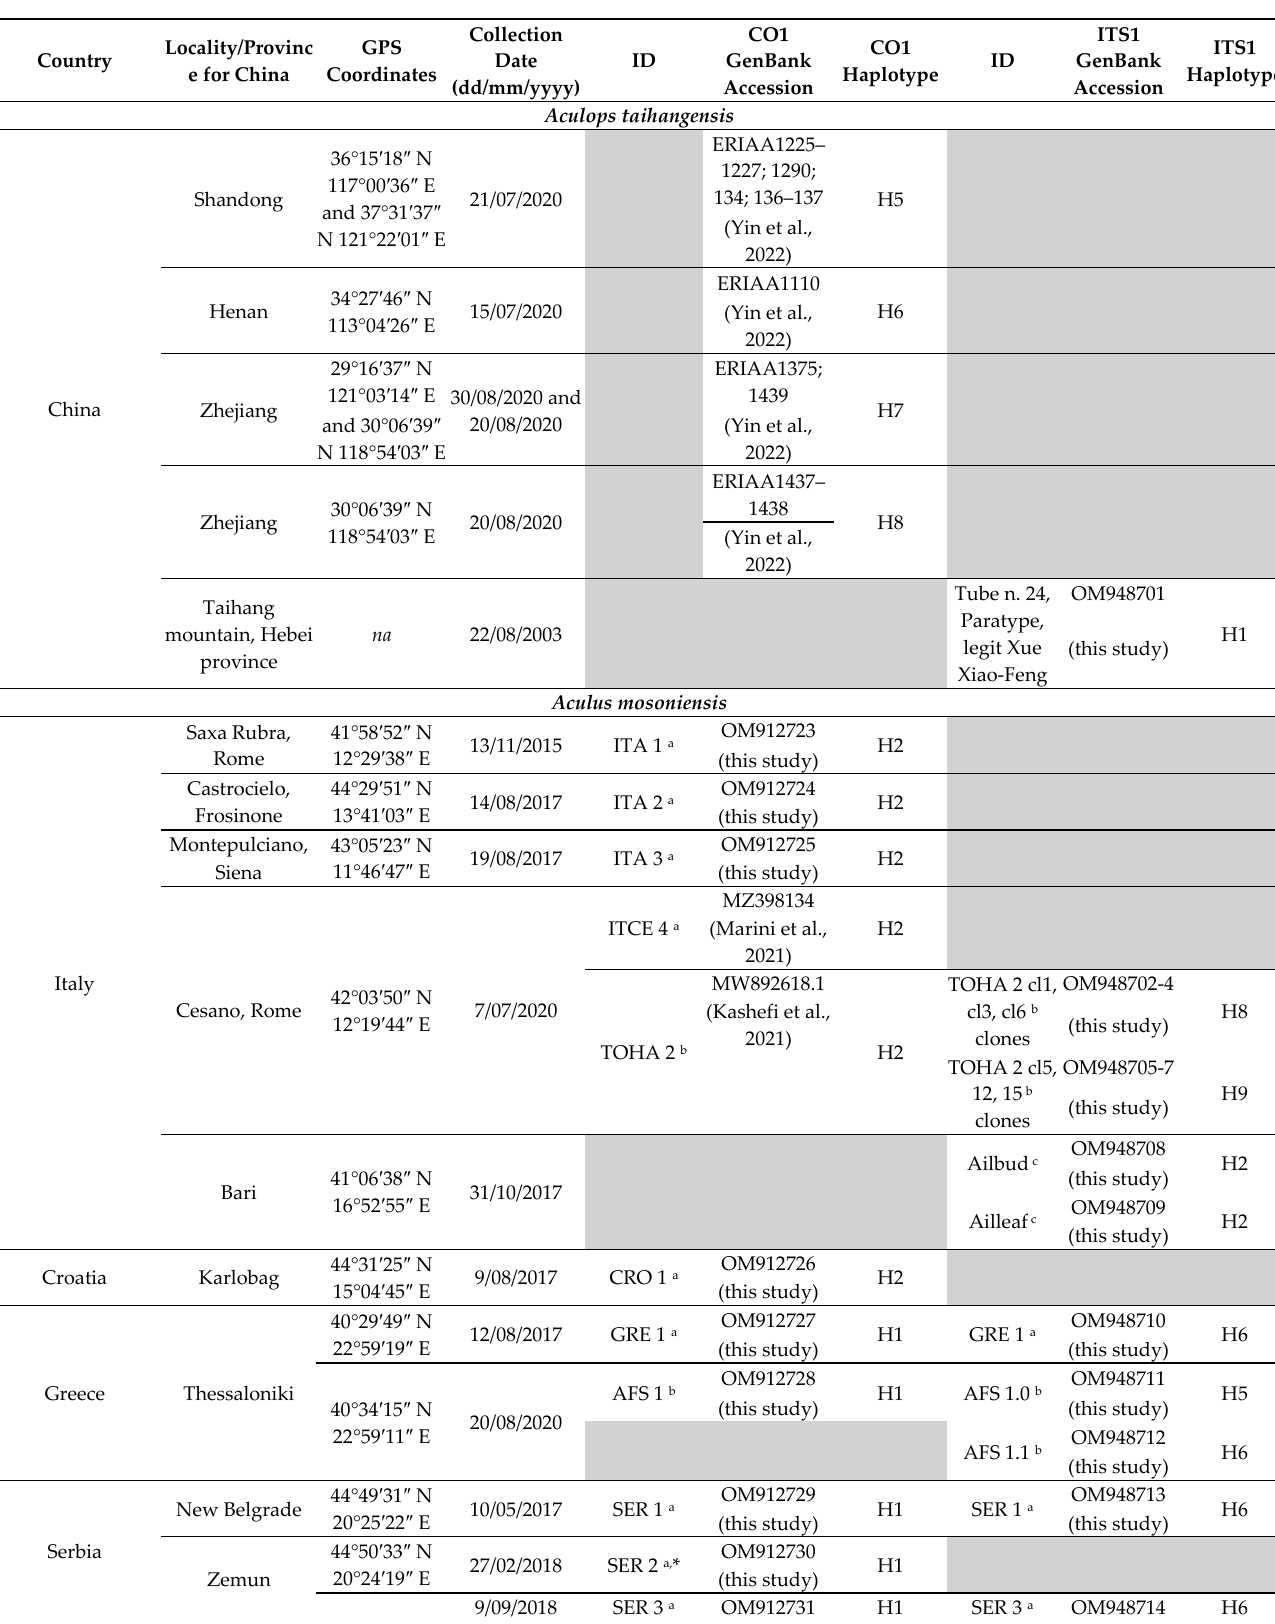
Table 1. Collection information of the Aculus mosoniensis populations and Aculops taihangensis specimens analyzed, and Genbank accession numbers (id = unique numbers for DNA extraction vouchers).